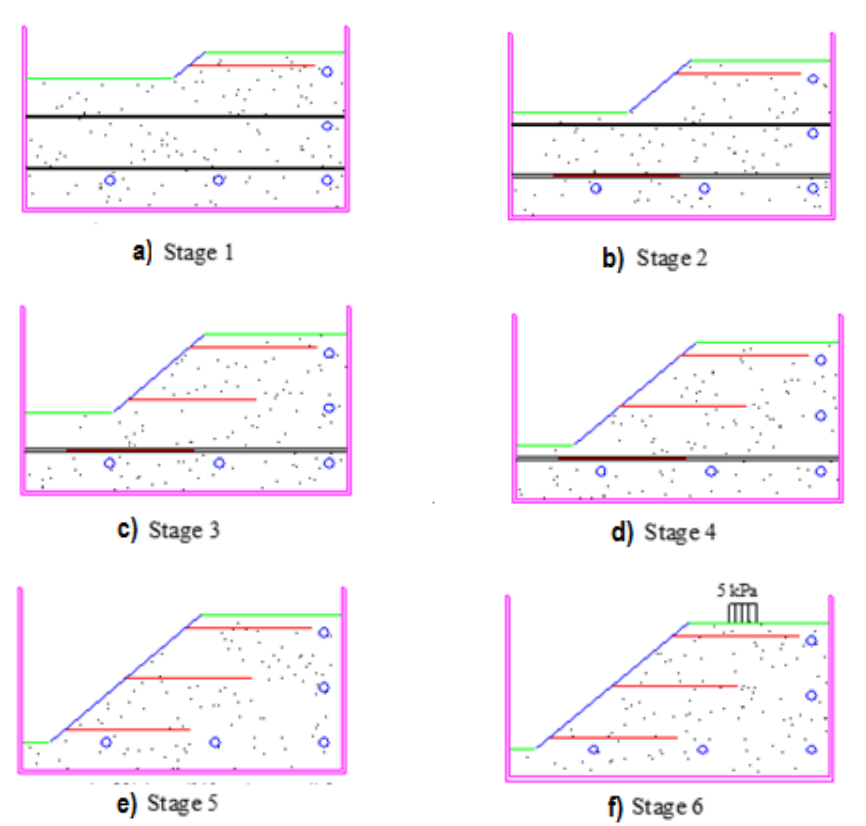
Figure 2. Construction stages of the slope-nailed system.